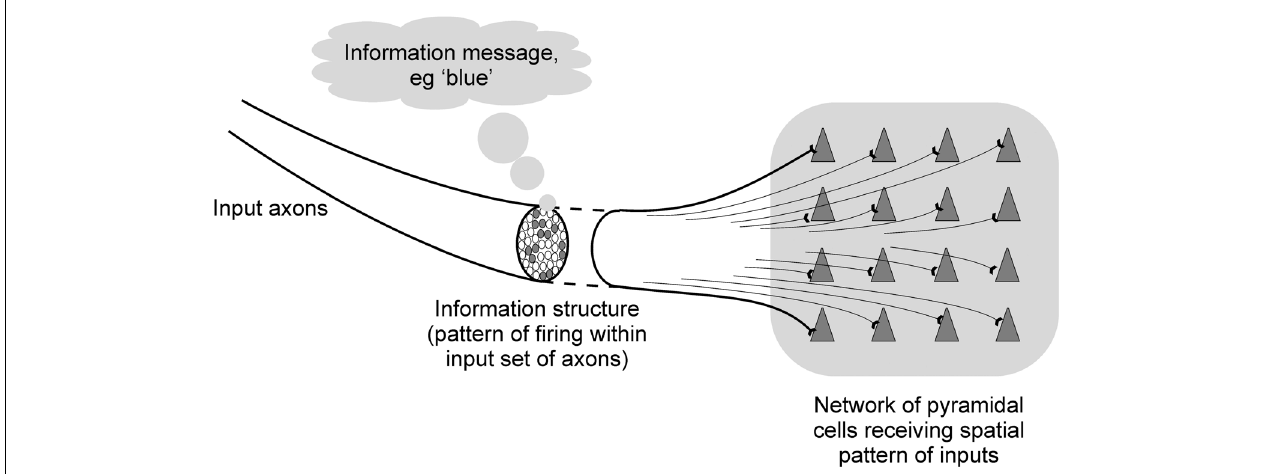
FIGURE 3 | Diagram illustrating the difference between information structures and information messages in cortical information